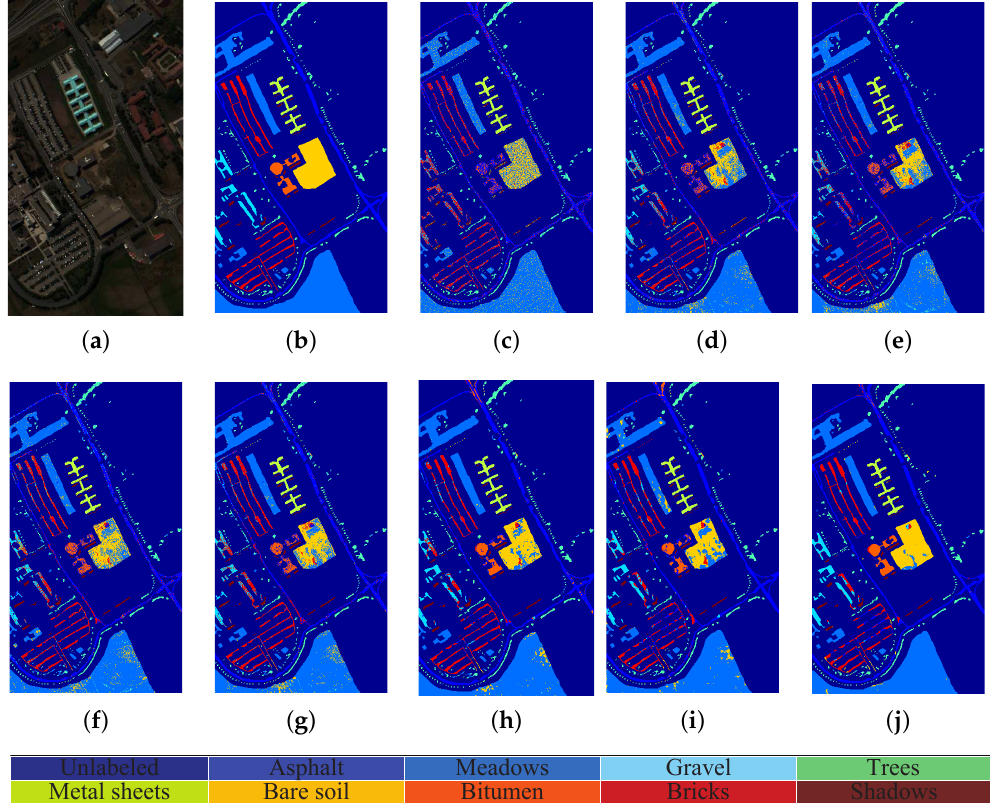
Figure 7. Classification maps of different methods for the Pavia University dataset: ( a ) Pseudocolor image, ( b ) ground truth, ( c ) LPP, ( d ) NPE, ( e ) SGE, ( f ) LRGE, ( g ) LatLRPL, ( h ) MPCA, ( i ) TLPP, ( j )